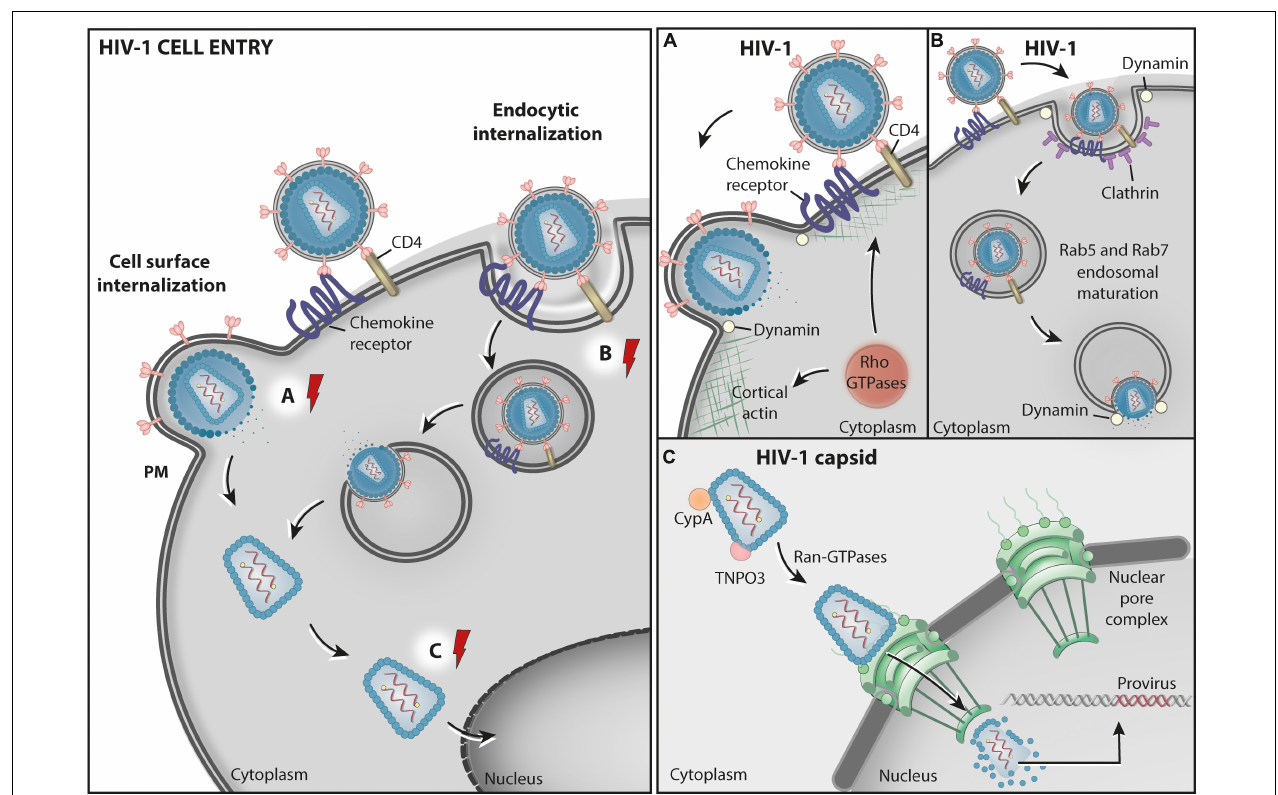
FIGURE 1 | HIV1 cell entry. Schematic representation of two proposed pathways for HIV-1 entry into cells. The cell surface internalization pathway involves the fusion between the viral envelope and the cell PM and is believed to be the main route for HIV entry into permissive CD4 expressing cells (A) – Rho GTPases: RhoA, Rac1, and Cdc42 participate in HIV-1 entry by promoting fusion complex stabilization, and fusion pore formation and expansion at the host cell surface through actin cytoskeleton remodeling. The HIV-1 entry pore is also stabilized by Dynamin GTPase activity, facilitating the release of the capsid containing the virus genome into the cytosol. In an alternative, poorly characterized, endocytic internalization entry pathway, HIV-1 particles are endocytosed via clathrin-coated vesicles (CCVs) and delivered to endosomes. (B) Dynamin GTPase activity is involved in both the formation of CCVs and the fusion between the virus and the endosome membrane. This pathway also involves Rab5 and Rab7 acting in endosomal maturation. (C) The viral capsid in the cytosol is transported to the nuclear pore by CypA, TNPO3, and the nuclear transporter GTPase Ran-GDP while the RNA is reverse transcribed into cDNA. At the nucleoplasm, the HIV-1 provirus is integrated into the host chromatin. The red electric ray symbols represent critical steps in the transport of viral factors that require